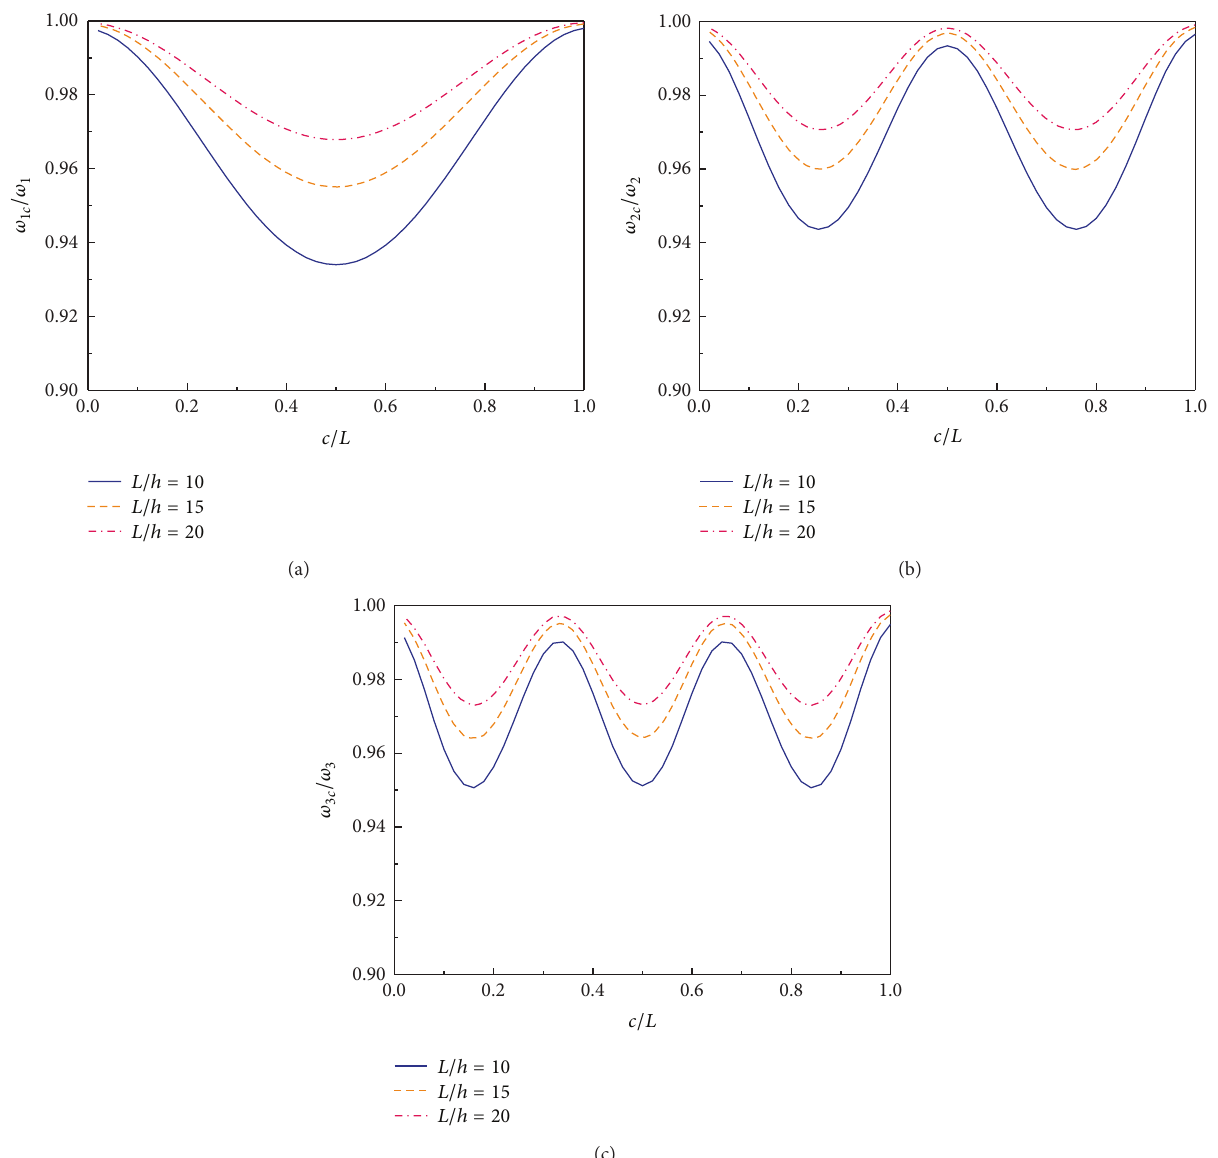
Figure 8: The first three frequency ratios of hinged-hinged FGM beams with different slenderness ratios and containing a single open edge crack (𝑎/ℎ = 0.3) at varying locations: (a) the fundamental frequency ratio, (b) the second frequency ratio, and (c) the third frequency